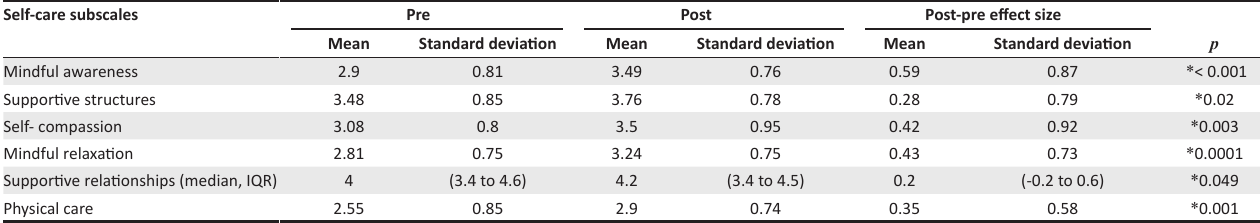
TABLE 1: Pre- and post-data of Mindful Self-Care Scale-short 2018. Self-care